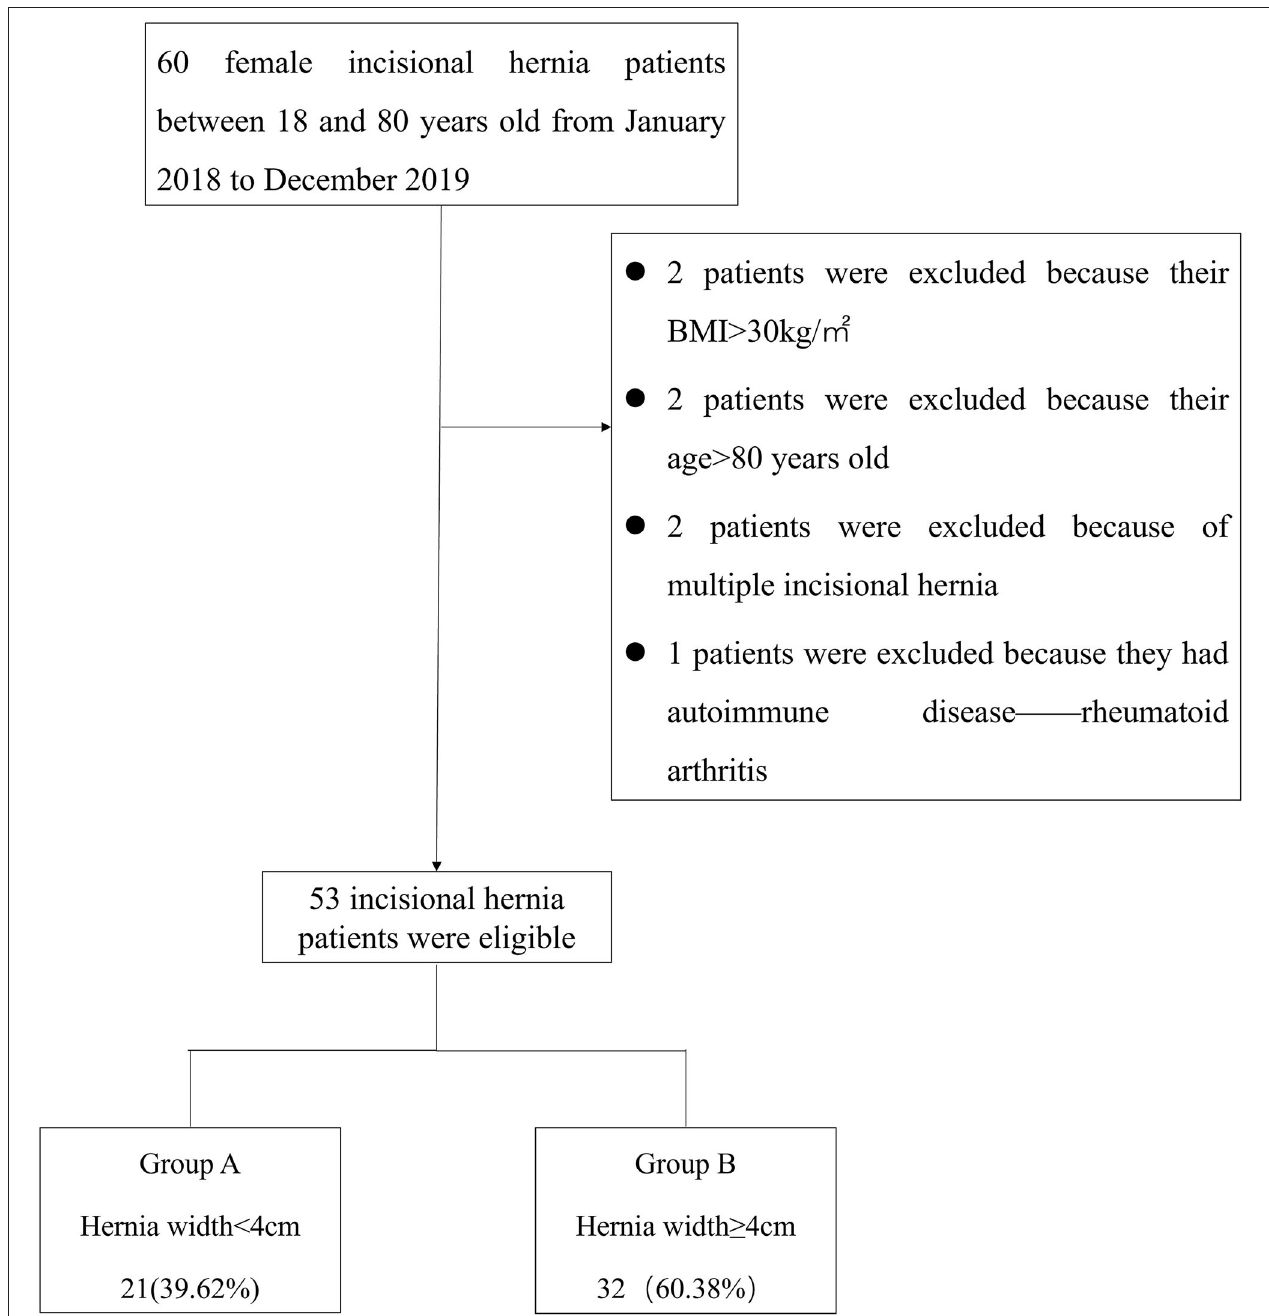
FIGURE 1 | Schematic for the classification of incisional hernia patients by hernia width.